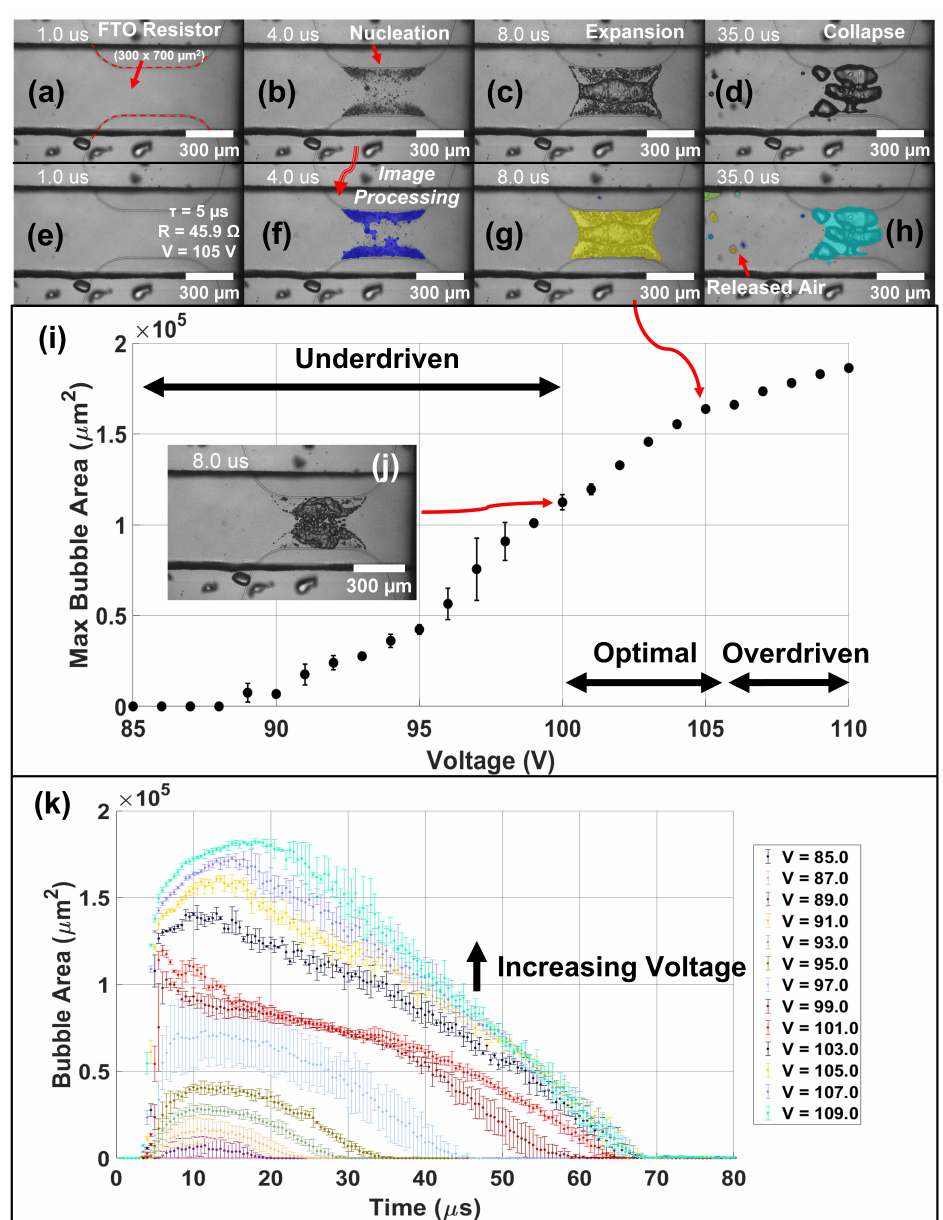
Figure 10. Closed Channel Femtosecond Resistor Characterization Intra-Device Reproducibility — illustrates the effect of voltage on the maximum bubble area for a 300 × 700 µ m 2 FTO (8 Ω /sq) resistor confined in a 515 × 315 µ m 2 U-shaped channel, as shown in Figure 6a, filled with water. The resistor has a 250 µ m fillet and firing parameters were as follows: pulse duration ( τ ) = 5 µ s, firing frequency (f) = 10 Hz, and resistance (R) = 45.9 Ω . ( a – d ) Show the bubble evolution over time in which ( e – h ) show the calculation of bubble area using background subtraction image processing. ( i ) Depicts the maximum bubble area as a function of applied voltage with inset ( j ) showing the maximum bubble area at t = 8 µ s for V = 100 V. ( k ) Illustrates the full time history of the bubble area during expansion and collapse phases as a function of voltage. Stroboscopic imaging was performed using a 1 µ s exposure time with a 500 ns light pulse for an effective 2 Mfps frame rate. N = 3 sample replicates were performed for each voltage level in which each sample is a different cycle of the same